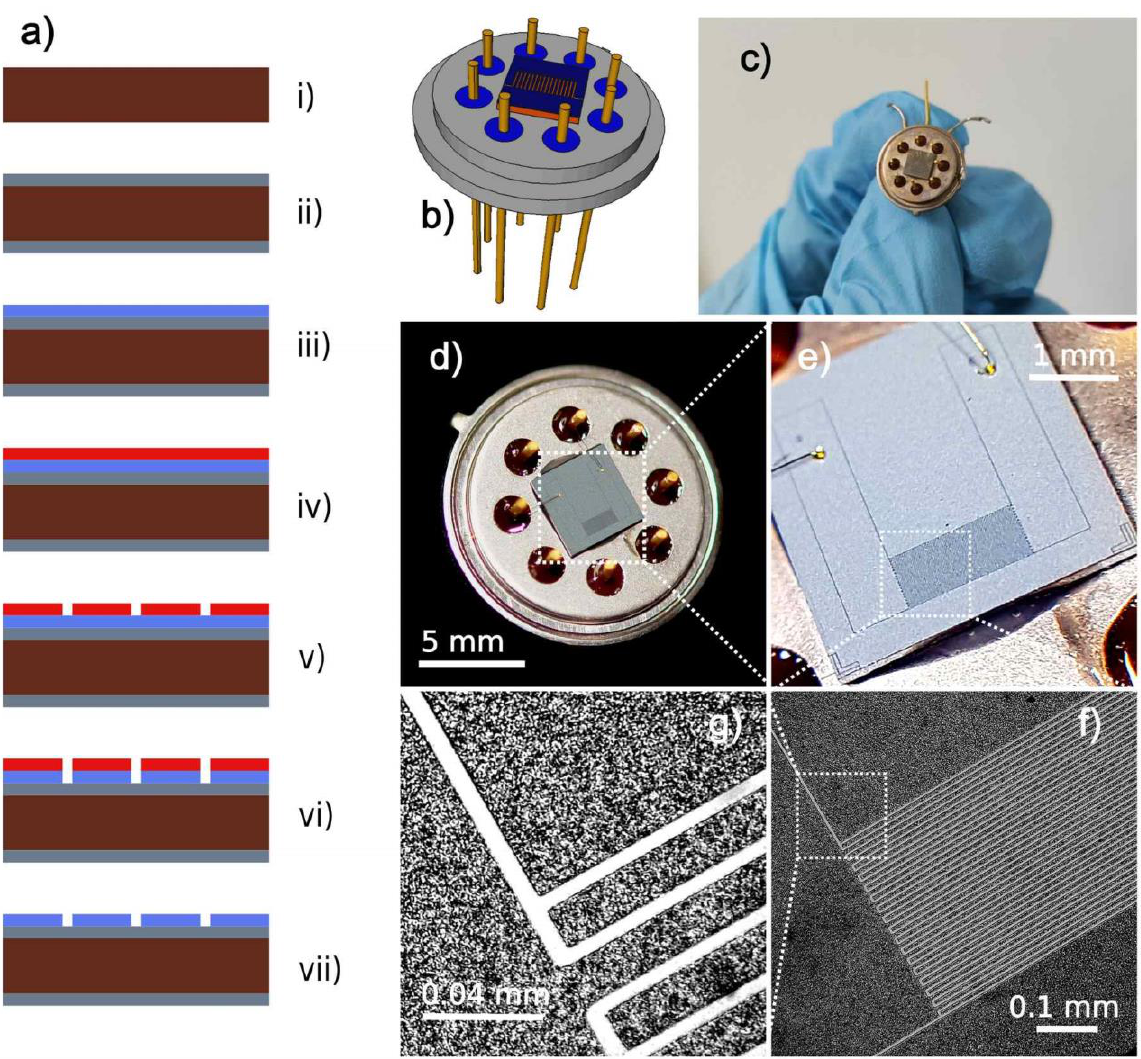
Figure 1. Fabricated sensor: ( a ) Schematic illustration of the fabrication process: ( i ) Untreated silicon wafer; ( ii ) Thermal oxidation; ( iii ) Aluminum thin film deposition by sputtering; ( iv ) Photoresist spin coating; ( v ) Optical lithography by direct laser writing; ( vi ) Aluminum wet etching; ( vii ) Photoresist removal. ( b ) Design of the chip on the housing, made by using 3D software (FreeCAD). ( c ) Photograph of the finished sensor mounted on a TO-8 housing and wire bonded; the diameter of the TO-8 housing is 13 mm, while the size of the diced chip is 3.8 mm. ( d ) Photograph of the finished sensor (scale bar is 5 mm). ( e ) Zoom into the sensor chip with a single battery, magnified by 3D stereo microscope (scale bar is 1 mm). ( f ) Zoom into the sensor digits magnified by optical microscope (scale bar is 0.1 mm). ( g ) Micrograph of the sensor surface by which the width of the digits was estimated at 0.015 mm, while the clearance between the digits was estimated at 0.005 mm (scale bar is 0.04 mm). In the approach presented in this paper, we actually modulate the output from a rectenna by applying various levels of humidity, Figure 2b. Instead of harvesting EM energy and leading the energy to the humidity sensor, the rectenna system is a humidity sensor itself, Figure 2b. The matching circuitry from Figure 2a is now replaced with an interdigitated capacitor made out of activated aluminum. In this way, we achieve humidity sensing where the same task would be much harder to accomplish by using a typical EM harvesting system and a humidity sensor powered by it.